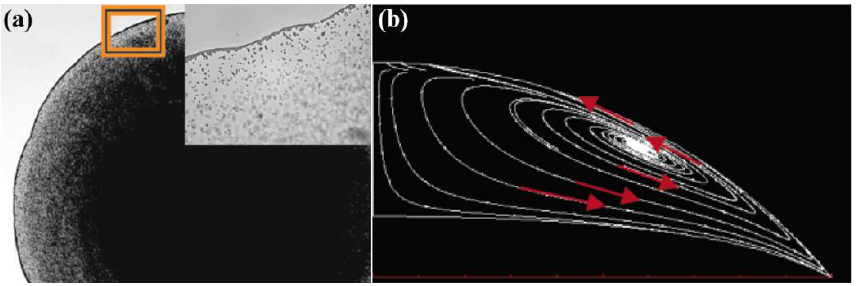
Figure 1. ( a ) Five times magnification image of a droplet with 0.5 wt% PS particles at 0.05 times after instillation. The inset is at 63× magnification of the particles gathered in the sphere line. Reproduced with permission [30]. Copyright 2012, American Chemical Society. ( b ) Theoretical flow field of the octane droplet showing Marangoni flow. Reproduced with permission [33]. Copyright 2006, American Chemical Society.